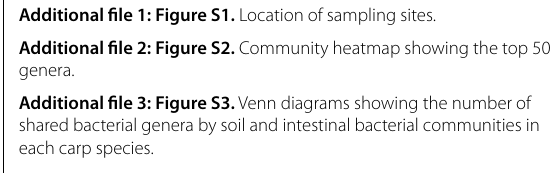
Additional file 2: Figure S2. Community heatmap showing the top 50 genera. Additional file 3: Figure S3. Venn diagrams showing the number of shared bacterial genera by soil and intestinal bacterial communities in each carp